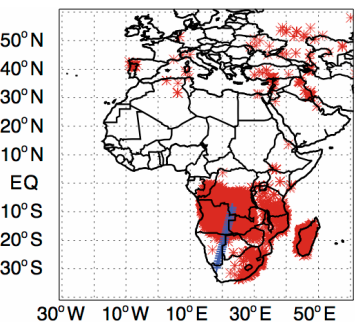
Figure 1. Collocated Suomi NPP CrIS measurements (blue cross) over Africa on 28 August 2013 and Terra MOPITT observations on 27 August 2013. The red stars represent the fire location measured by Aqua MODIS on 28 August 2013.